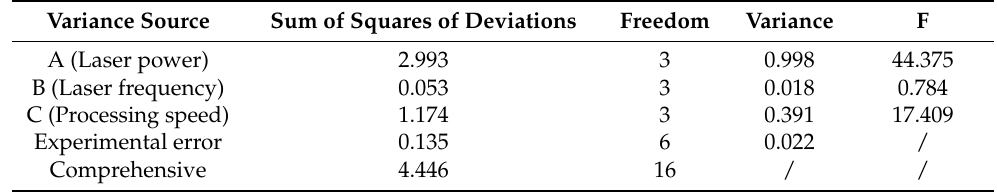
Table 11. Variance analysis of over-frequency rate.